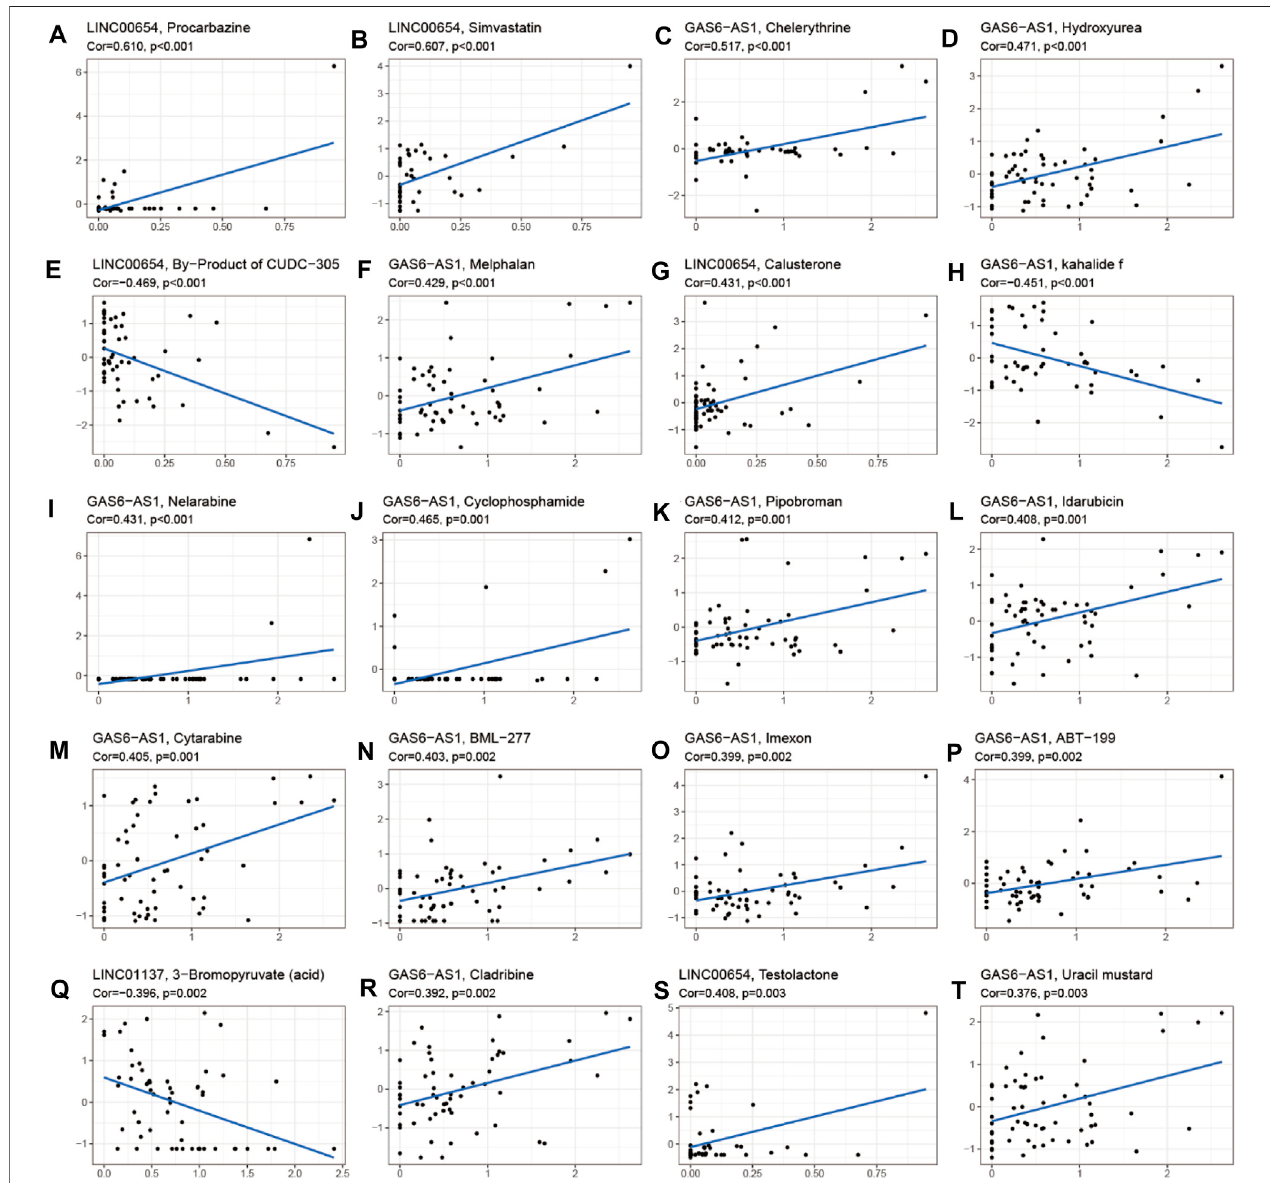
FIGURE 14 | Correlation analysis between m 6 A-related lncRNAs and sensitivity to anticancer drugs in CellMiner. Top 20 statistically signi fi cant correlations between prognostic m 6 A-related lncRNAs and sensitivity to anticancer drugs.